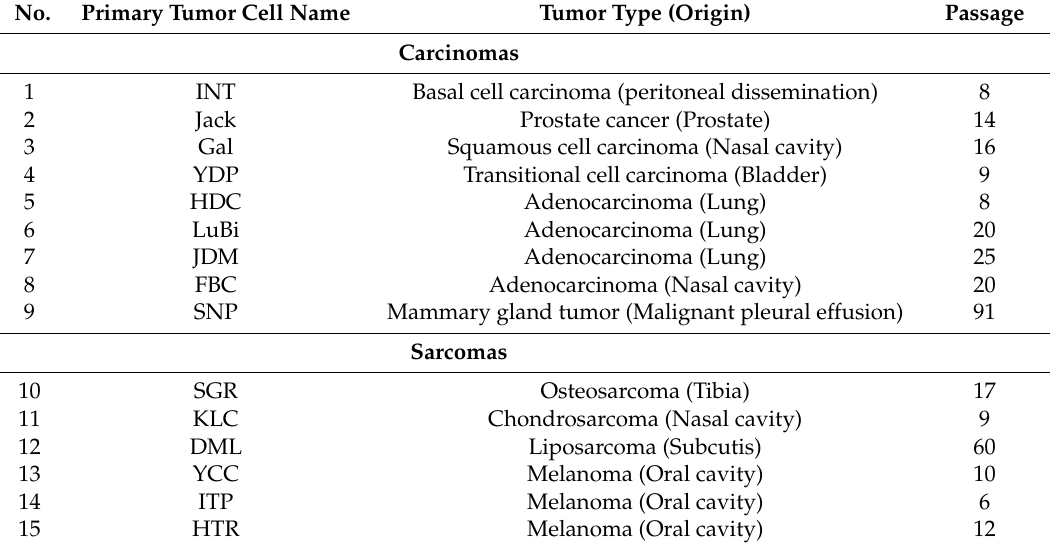
Table 5. Primary tumor cell lines used in this